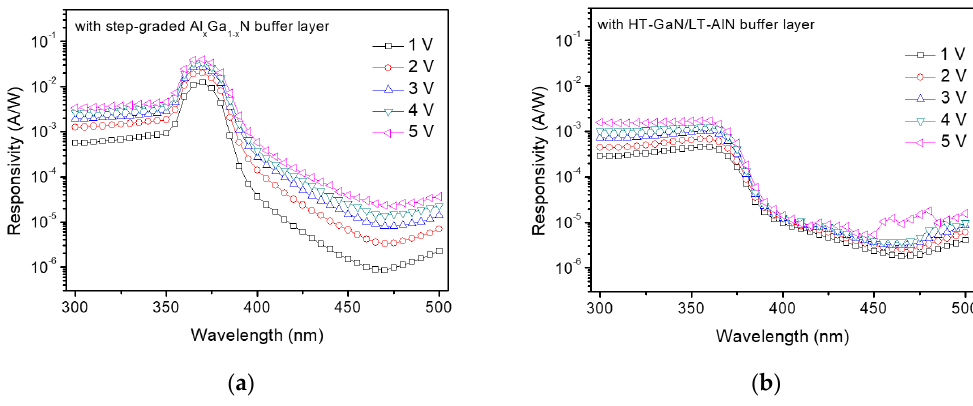
Figure 4. Spectral photoresponsivity characteristics of GaN MSM UV photodetectors with ( a ) the step-graded Al x Ga 1 − x N buffer layer and ( b ) HT-GaN/LT-AlN buffer layer, indicating significantly increased photoresponsivity of the GaN MSM UV photodetector with the step-graded Al x Ga 1 − x N buffer layer near 365-nm wavelength region (UV-A region).